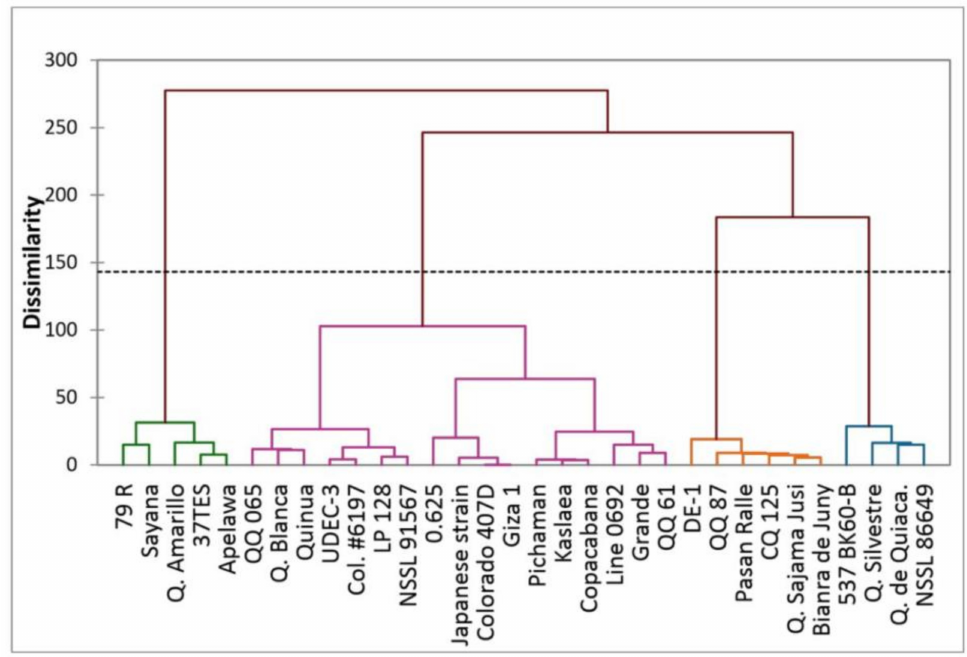
Figure 3. Agglomerative hierarchical clustering (AHC) of quinoa genotypes based on the morpho- logical traits using the standardized Euclidean distances